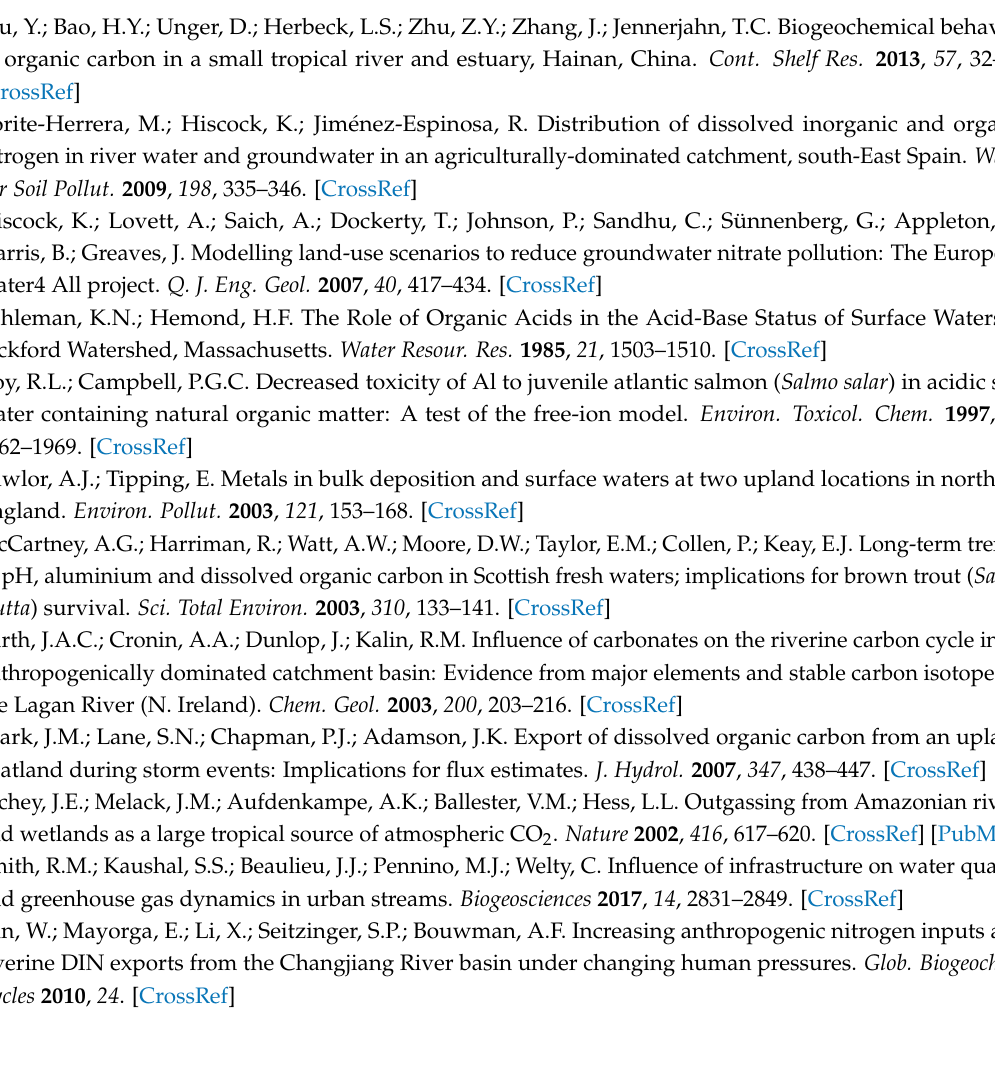
Table S1: The sampling locations, water parameters, and chemical compositions of Mun River water; Table S2: DOC and DON concentrations of worldwide